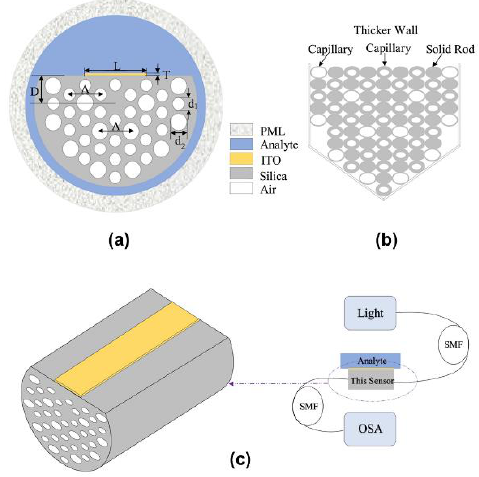
Figure 4. ( a ) Cross-section schematic of the sensor, ( b ) stacked structure of the sensor, and ( c ) 3D illustration of the sensor. The figure in Liu et al. [48] is reprinted with permission from